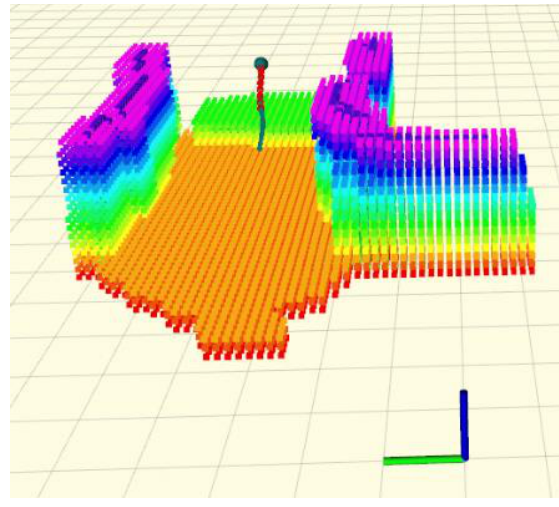
Figure 6. Visualization of local trajectory planning.